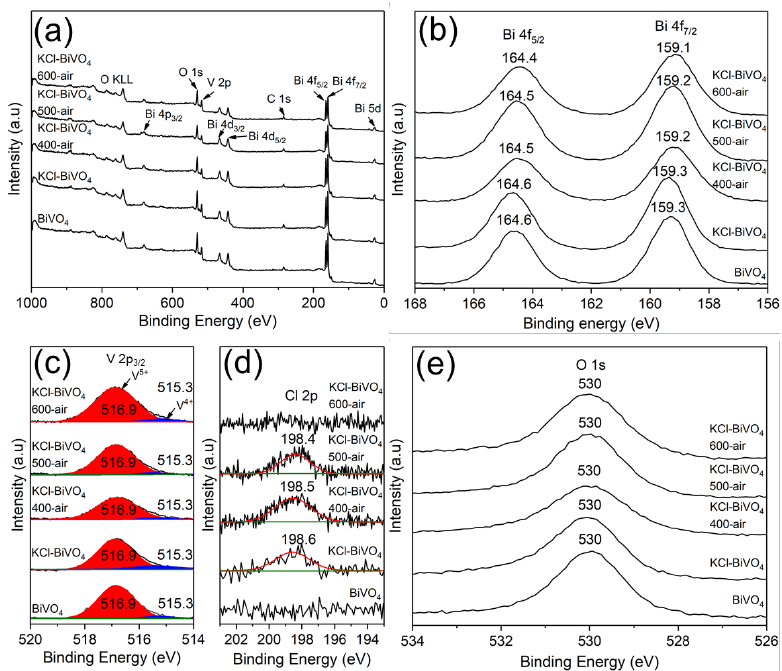
Figure 4. XPS spectra of BiVO 4 and KCl-BiVO 4 samples calcined in the air at various temperatures: ( a ) survey spectra, and high-resolution spectra of ( b ) Bi 4f, ( c ) V 2p, ( d ) Cl 2p, and ( e ) O 1s orbitals. Table 1. XPS peak areas (relative %) of V 5+ and V 4+ from V 2p 3/2 , estimated % oxygen vacancy ( V o in %) and bandgaps ( E g in eV) of pristine BiVO 4 , KCl-BiVO 4 and various KCl-BiVO 4 samples calcined